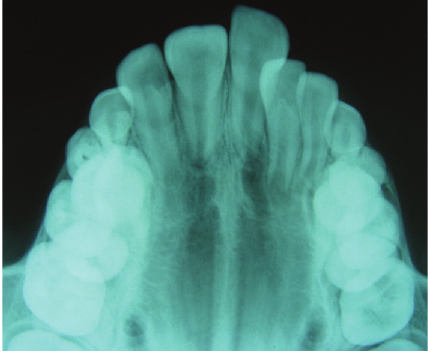
Figure 5: Occlusal radiograph showing talon cusp on 12 and 22; fusion of 22 and supplemental supernumerary 22.